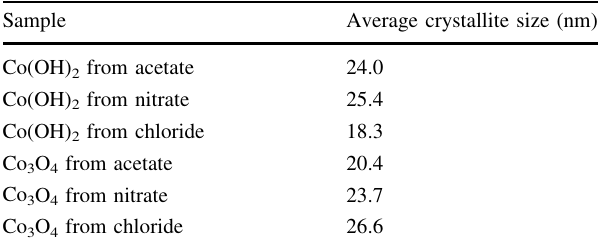
Table 1 Average crystallite size of cobalt oxide coatings, deposited from different electrolyte baths, calculated according to Sherrer’s equation